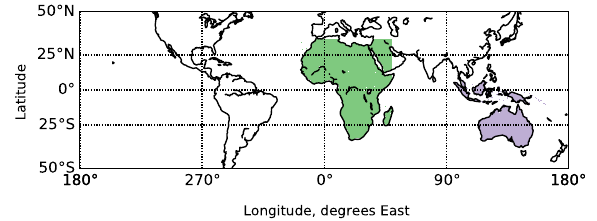
Fig. 5 A map illustrating the regions of the land surface temperature override. The colors indicate the regions "Africa" (green) and Maritime&Australia" (purple) used in the experiments with the land surface temperature override (see Methods).